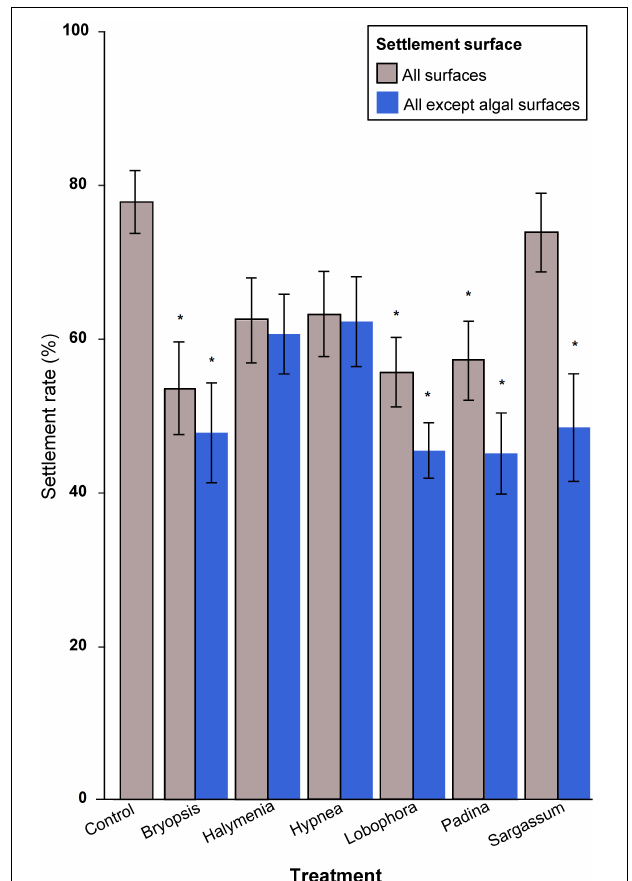
FIGURE 1 | Mean percentage larval settlement across all treatment groups for all algae substrate treatments. All macroalgae species labels in this figure are simplified to their respective genus names. The symbol ∗ denotes significant differences in settlement percentages in comparison to the control treatment ( post hoc Tukey HSD; p -value < 0.05) in all surfaces (gray bars) and settlement excluding leaf blade surfaces (blue bars), respectively. Error bars represent standard errors ( ±